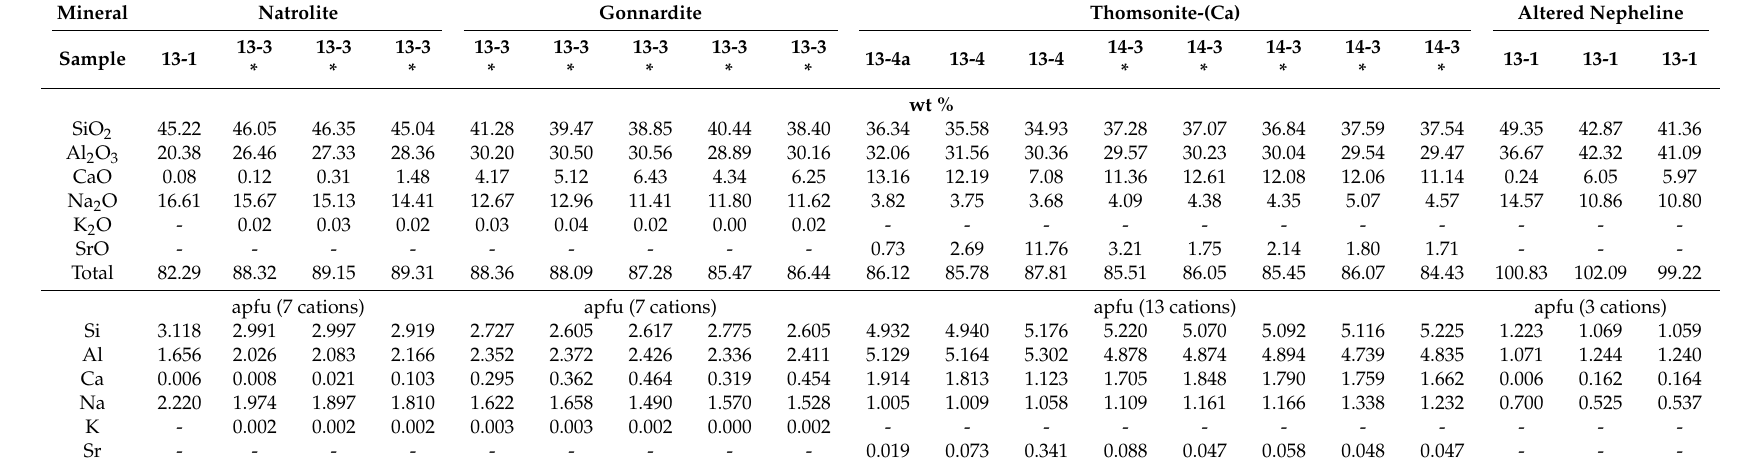
Table 4. Chemical analyses of zeolite group minerals and “altered nepheline” from Breivikbotn